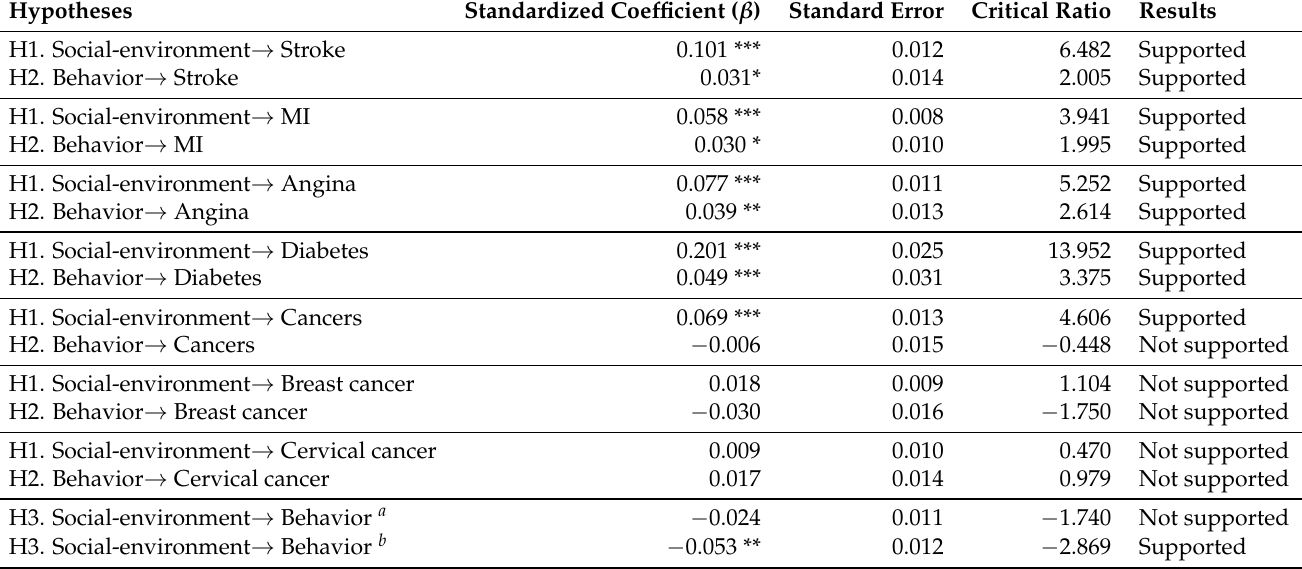
Table 2. The results of the research